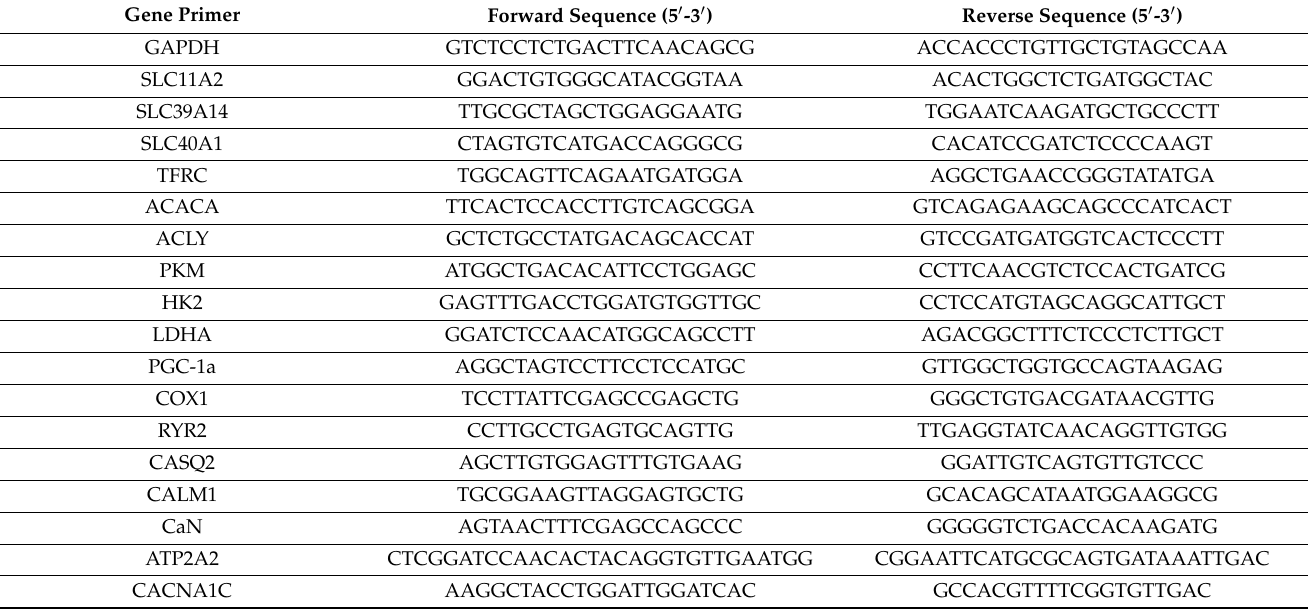
Table 1. Primer sequences used for SYBR Green